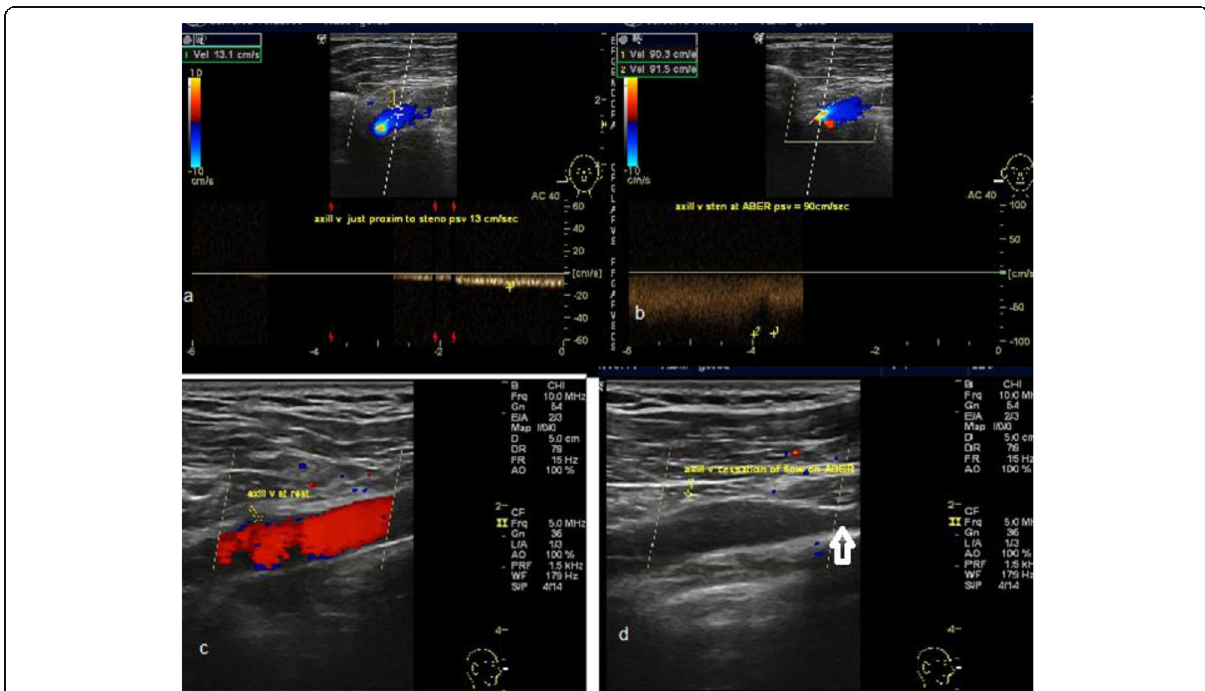
Fig. 5 a – d Ultrasound images showing significant stenosis of the compressed vein segment at the costo-clavicular tunnel as evidenced by significant rise in the velocity ratio > 6.5 (13 cm/sec in neutral position seen in a reaching (90cm/sec in arm abduction and external rotation seen in b . c Color image for the axillary vein in the resting position but with abduction and external rotation (ABER) almost total cessation of flow was noted in d with peaked narrowing at the costo-clavicular outlet (white